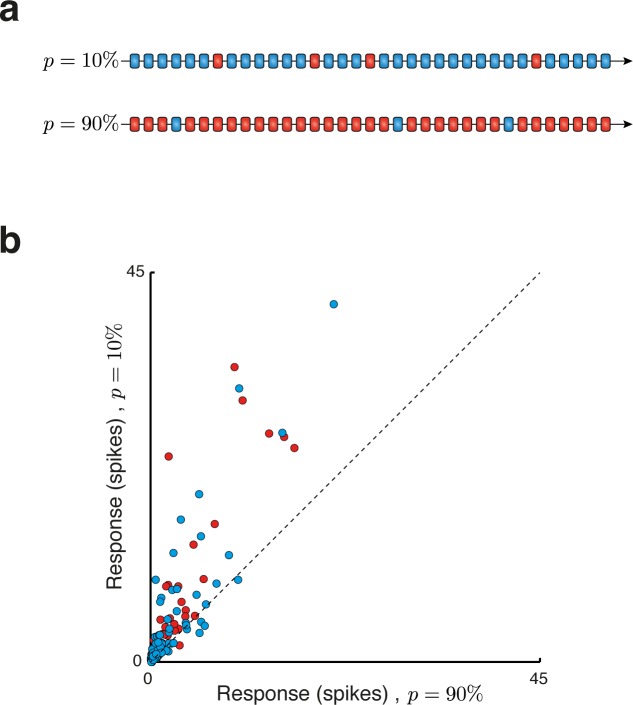
Neural responses in the oddball paradigm.(a) Two examples of oddball stimuli blocks, one with p = 10% and the other with p = 90%. Different colors (blue and red) represent the two stimuli (‘low’ and ‘high’ tones of the oddball sequences). (b) Single-neuron responses in cat primary auditory cortex (A1) to auditory oddball stimuli. Each point shows the average spike counts of one neuron to the same stimulus (either low-tone or high-tone, represented by different colors) when presented in the p = 10% block versus the same physical stimulus in the p = 90% block. Note that most dots fall above the diagonal, indicating stronger response to rare stimuli.